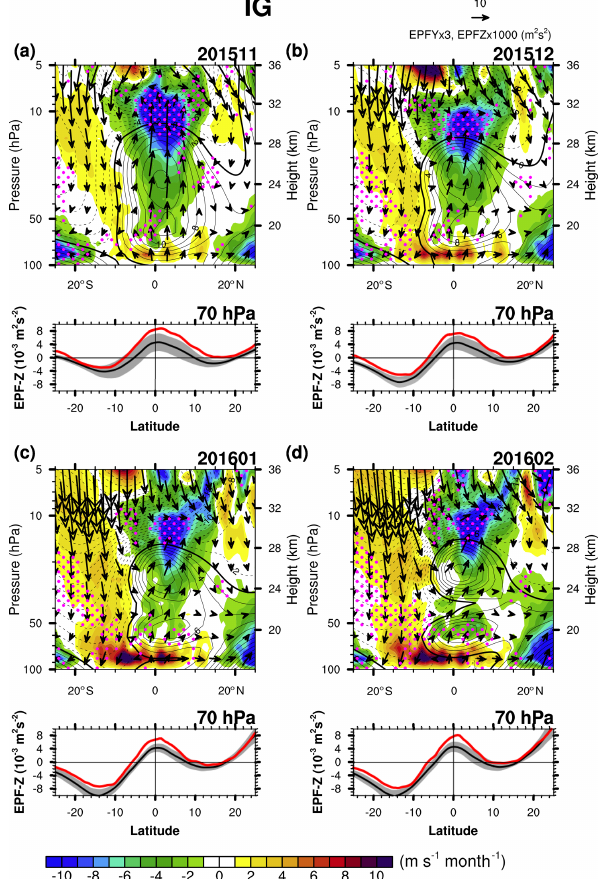
Figure 11. Latitude–height cross sections of the EP flux (vectors) divided by air density and EP flux divergence (shading) for the IG waves (multiplied by 4) with the (bottom) vertical EP flux for the IG waves at 70hPa in (a) November 2015, (b) December 2015, (c) Jan- uary 2016, and (d) February 2016 (red), along with their monthly climatology (black) with ± 1SD (gray shading). Positive (negative) zonal winds are plotted with solid (dashed) lines with a contour in- terval of 2ms − 1 , and thick contour lines denote a zero zonal wind speed. The magenta stippled pattern represents a region where the EPD is algebraically smaller (more negative) than the climatology by more than its SD. Here, EPF and EPD are multiplied by 8 and 4,